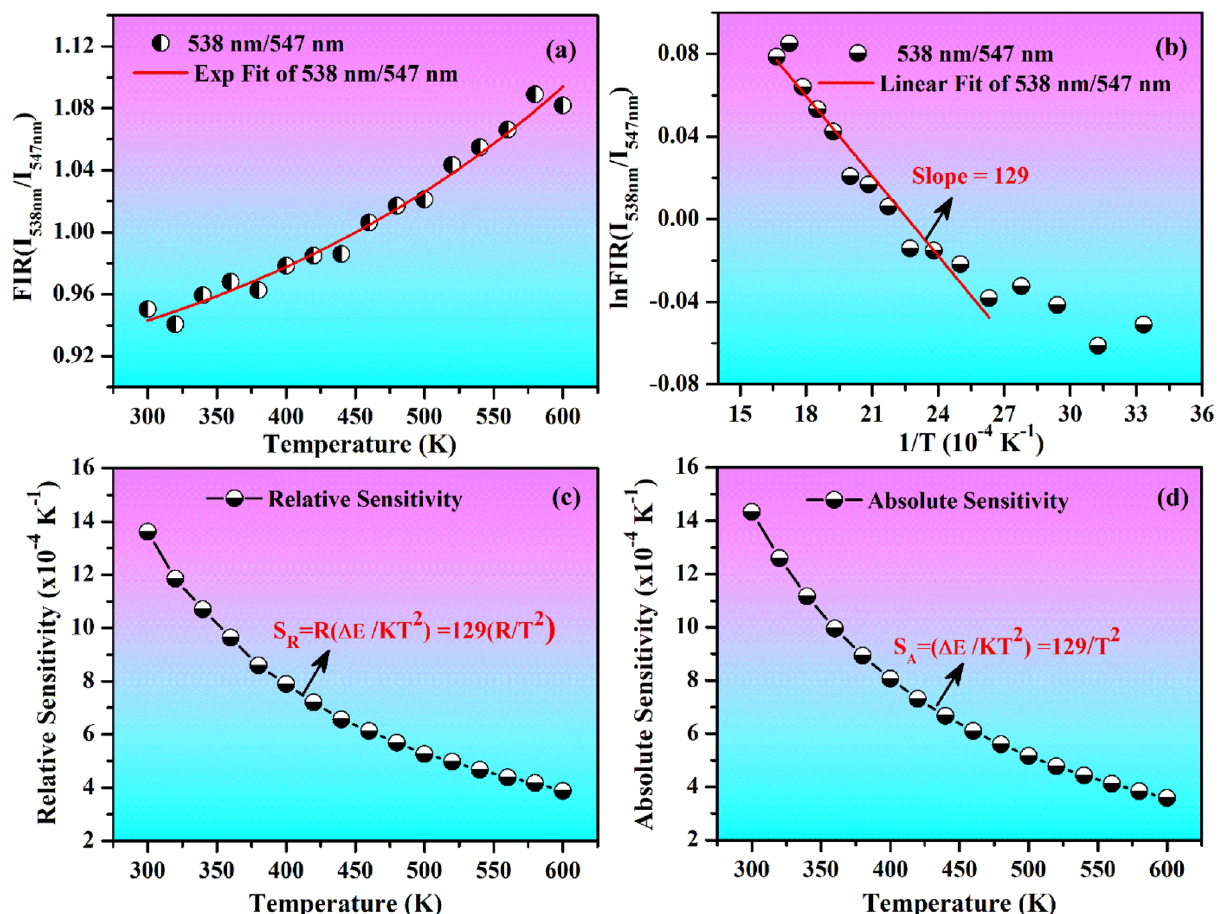
Figure 13. ( a ) Plots of FIR(I 538nm /I 547nm ) versus temperature, ( b ) lnFIR(I 538nm /I 547nm ) ~ T −1 ( c ) Relative sensitivity ~ temperature and ( d ) Absolute sensitivity ~ temperature for the Ho 3+ /Yb 3+ /5Bi 3+ co-doped ZnGa 2 O 4 phosphor under 980 nm excitations at 12.73 W/cm 2 .